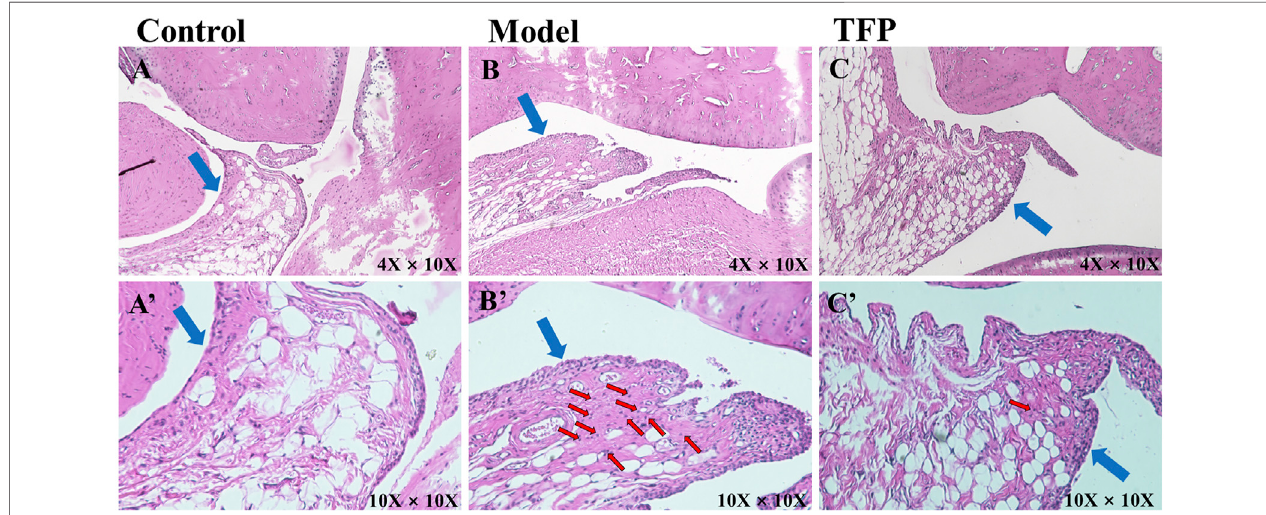
FIGURE 2 | H and E staining of ankle joint tissue (×10 objective lens on a microscope); the blue arrows point at synovium and the red arrows point at in fl ammatory cell in fi ltration. (A) / (A ’ ) : Joint tissue slice of rats in Control group (4X/10X eyepiece); (B) / (B ’ ) : Joint tissue slice of rats in Model group (4X/10X eyepiece); (C) / (C ’ ) : Joint tissue slice of rats in TFP group (4X/10X